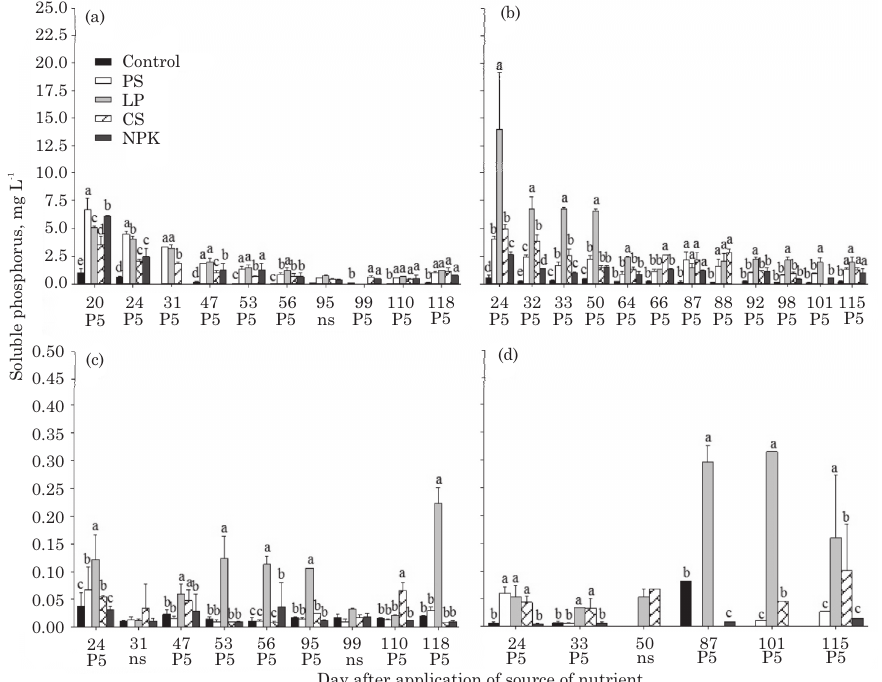
Figure 3. Soluble phosphorus content in the runoff solution on the soil surface from black oat (a) and maize (b); and in the leached solution from black oat (c) and maize (d), in a Typic Hapludalf treated with nutrient sources. P5: significant at 5 % probability by the Scott-Knott test; ns: not significant at 5 %